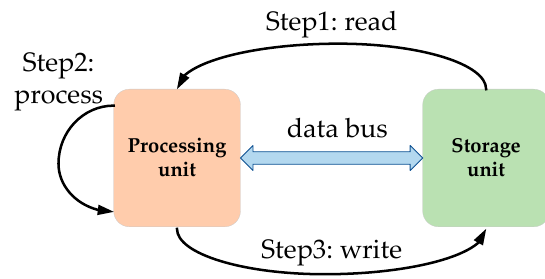
Figure 2. Visualization of the synthetic aperture radar (SAR) raw data and SAR image (point target imaging).